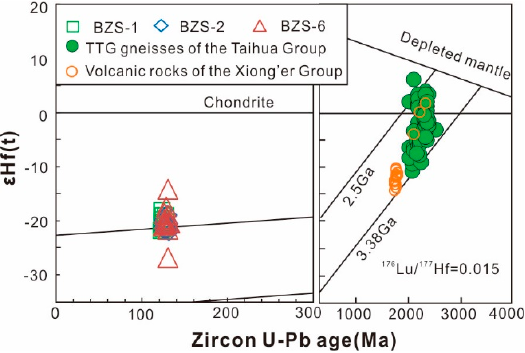
Figure 6. Variations in the initial ε Hf values versus the U-Pb ages of the zircons from the Banzhusi granite porphyry. Data include zircons from the Taihua Group [30] and Xiong’er Group [38]. Minerals 2019 , 9 , x FOR PEER REVIEW